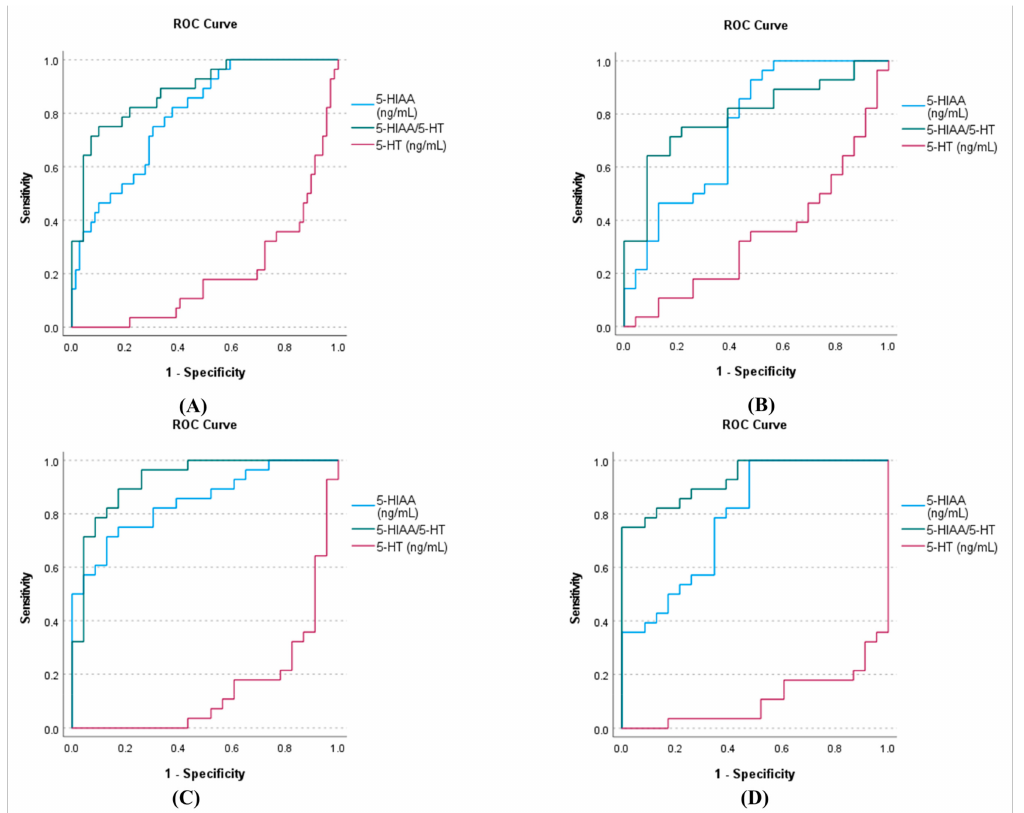
Figure 4. AUC analysis of 5-HT, 5-HIAA, and 5-HIAA/5-HT for VAKI in the VAKI group and non-VAKI subgroups. Notes: The AUC analysis of 5-HT, 5-HIAA, and 5-HIAA/5-HT was performed ( A ) for the VAKI group and all of the non-VAKI subgroups, ( B ) for the VAKI group and infection subgroup, ( C ) for the VAKI group and CKD subgroup, and ( D ) for the VAKI group and HC subgroup. Abbreviations: VAKI, vancomycin associated acute kidney injury; CKD, chronic kidney disease; HC, healthy control; 5-HT, serotonin; 5-HIAA, 5-hydroxyindoleacetic acid; 5-HT/Trp, the ratio of 5-hydroxyindoleacetic acid to